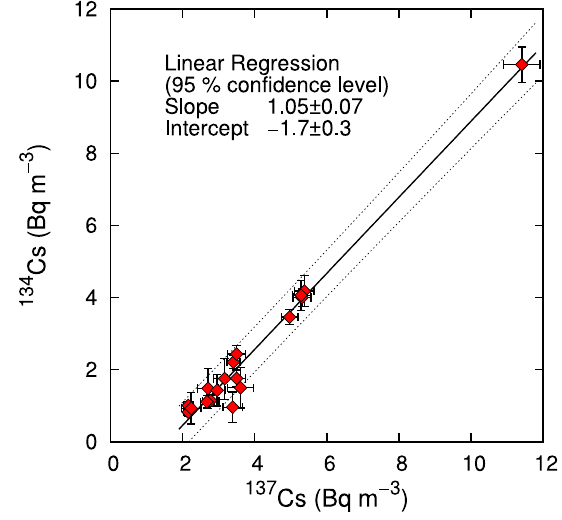
Fig. 4. The activities of 134 Cs and 137 Cs in analyzed surface sea- water from the North Pacific Ocean. The linear fit of the data is rep- resented by straight line (solid) and 95% confidence limits (dashed